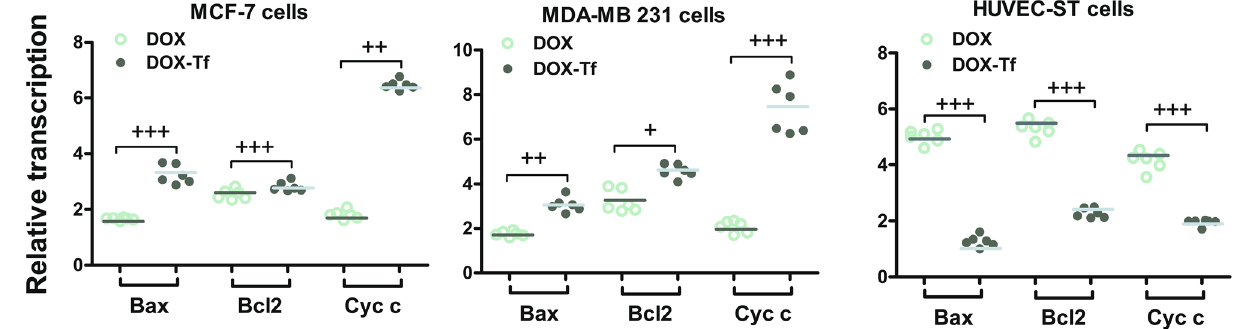
Figure 8. Expression of Bax, Bcl2 and Cytochrome c gene transcripts (relative to HPRT1 housekeeping gene) in MCF-7, MDA-MB-231 and HUVEC-ST cells exposed to IC 50 concentrations of DOX or DOX–Tf. Asterisks refer to the level of significant ( + p < 0.05, ++ p < 0.01, +++ p < 0.001; n = 6) difference between expression in the cells treated with DOX or